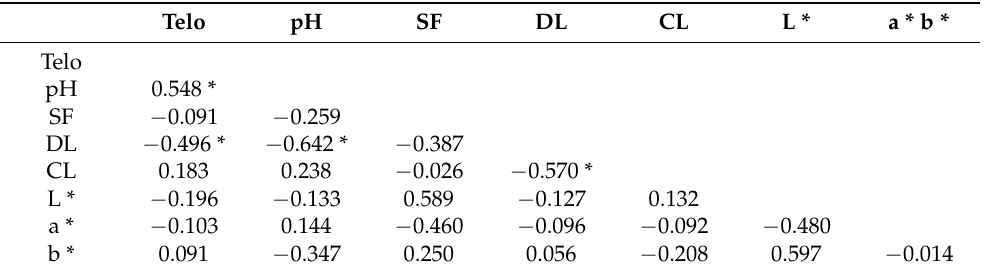
Table 10. Correlations between telomere length and meat quality traits of the CORT chickens versus control chickens at week 2.